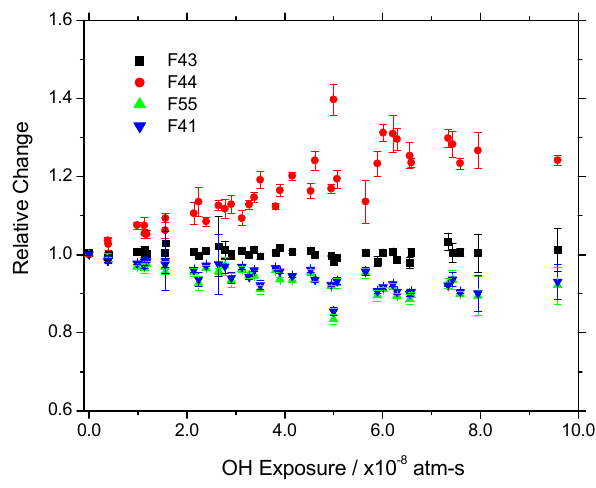
Fig. 3. Relative changes in F41, F43, F44 and F55 with OH ex- posure for all SOA types, i.e. SOA1, SOA2 and SOA3 data are all plotted together. Error bars represent one standard deviation of av- erage